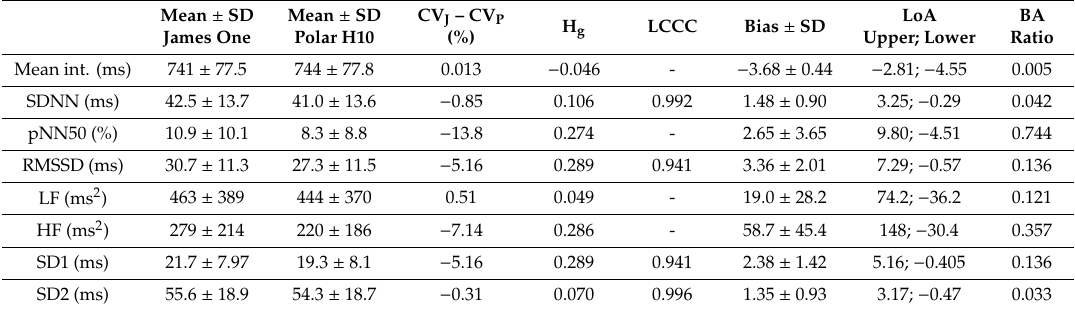
LoA Upper; Lower